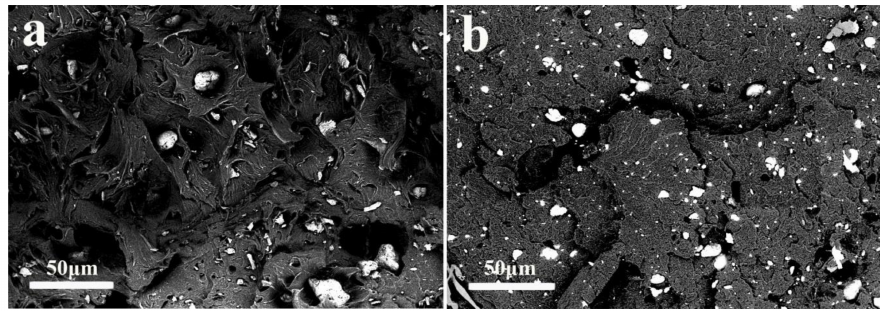
Figure 5. SEM micrograph of iPB/MCC composites ( a ) iPB/MCC5; ( b )